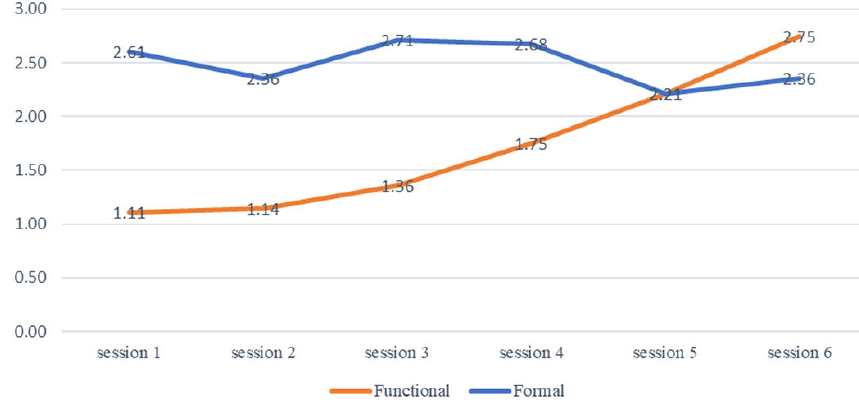
Fig. 2. The average no. of formal and functional transformations during the design sessions (Researcher)